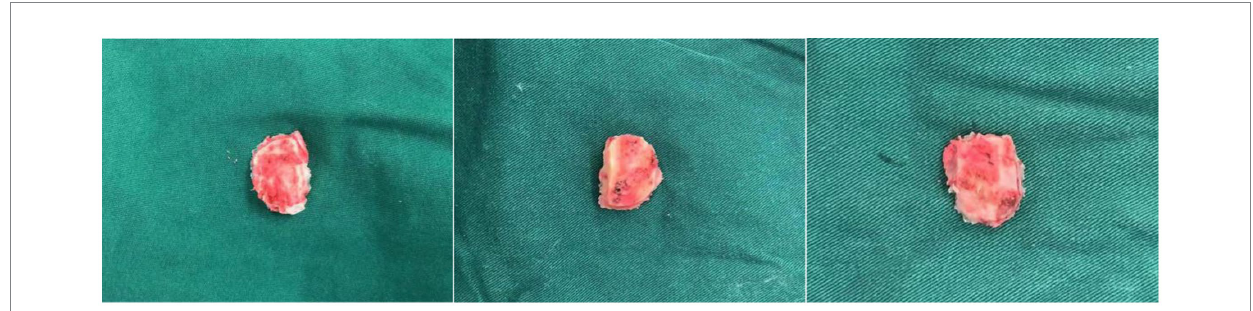
FIGURE 6 Bone flaps using improved methods. Intraoperative adjustments in bone flap dimensions were